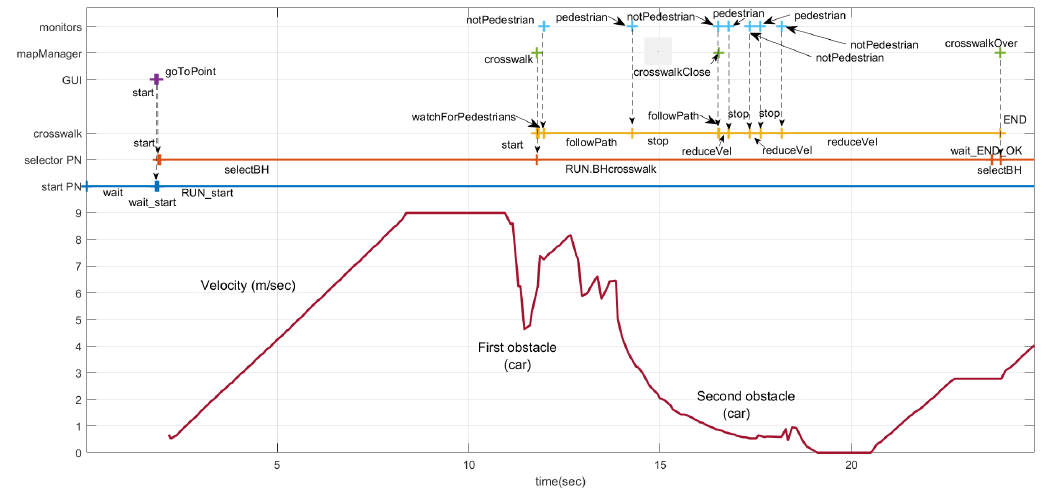
Figure 20. Temporal diagram for entering a roundabout scenario. At the top, the events produced by modules monitors, mapManager, and GUI. In the middle, the evolution of crossWalk, yield, selector, and start PNs. At the botton, the velocity commanded to the